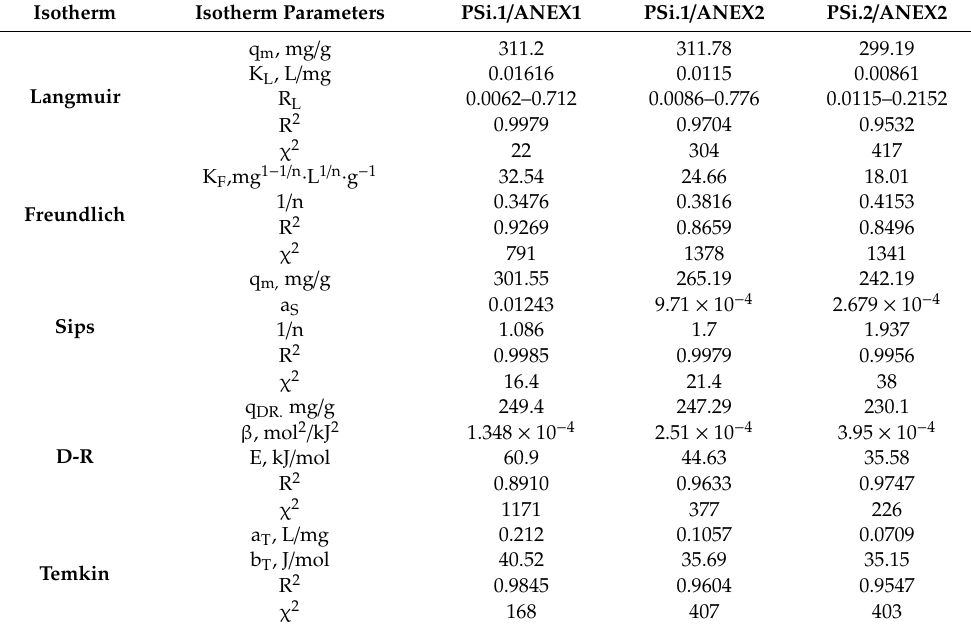
Figure 7. Sorption isotherms of Cr(VI) onto PSi.1 / ANEX1 ( a ), PSi.1 / ANEX2 ( b ), PSi.2 / ANEX2 ( c ), and removal efficiency as a function of number of sorption / desorption cycles ( d ); sorption conditions: sorbent dose 1 g / L, pH 4, temperature 23 ◦ C, contact time 6 h; desorption conditions: 0.1 M NaOH, 6 h, pH 4. Table 2. Isotherm model parameters of Langmuir, Freundlich, Sips, Dubinin-Radushkevich (D-R), and Temkin models for the sorption of Cr(VI) onto the porous silica / ANEX composite sorbents, at 23 ◦